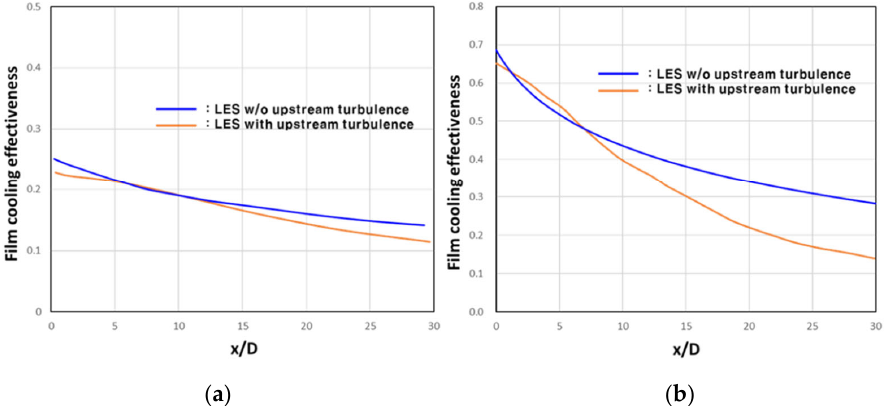
Figure 10. ( a ) Laterally averaged film cooling effectiveness distribution and ( b ) film cooling effectiveness along the centerline at the blowing ratio of 2.0 according to the upstream turbulence.